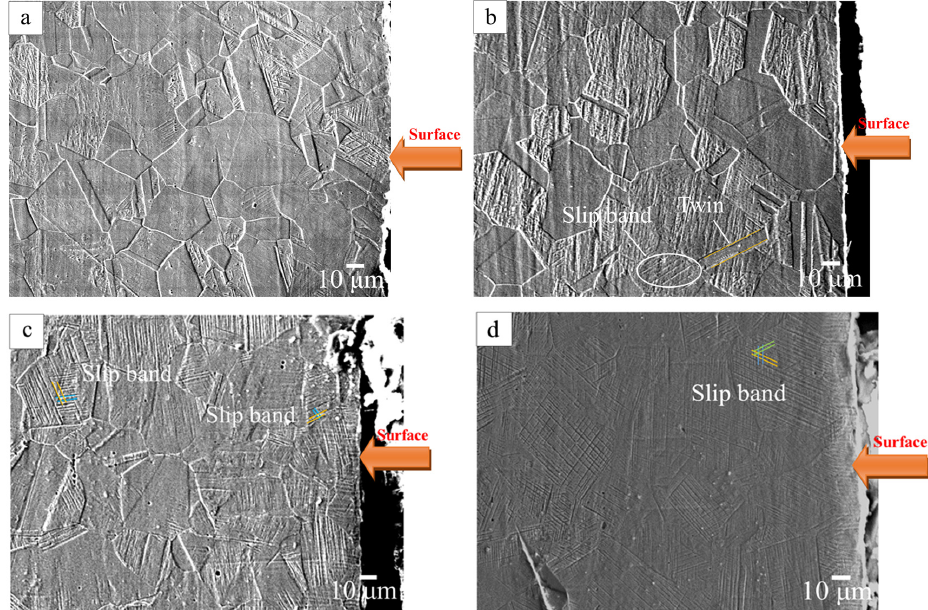
Figure 4. SEM of a section of the surface microstructures of the base metal zone of the 316L stain- less steel samples after different laser shock peening: ( a ) substrate, ( b ) peening once, ( c ) peening twice, and ( d ) peening three times.